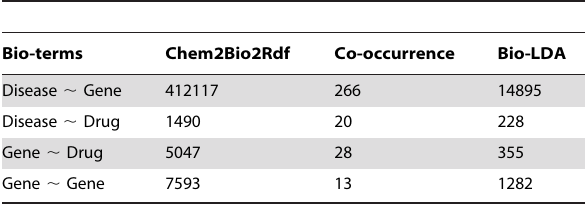
Table 8. Comparing the co-occurrence method and the Bio- LDA in identifying associated